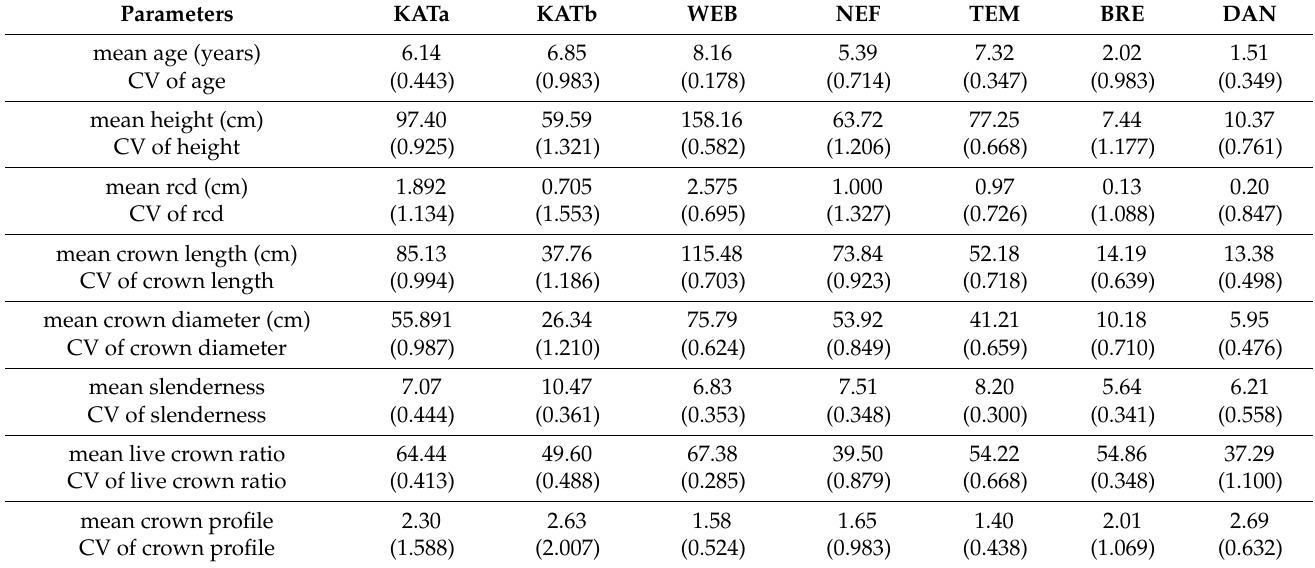
Table 3. Mean values and coefficients of variation (CV in brackets) of the growth characteristics of pine seedlings (slenderness (height/rcd), live crown ratio (crown length relative to tree height), crown profile for all trees with established branches (crown length/crown